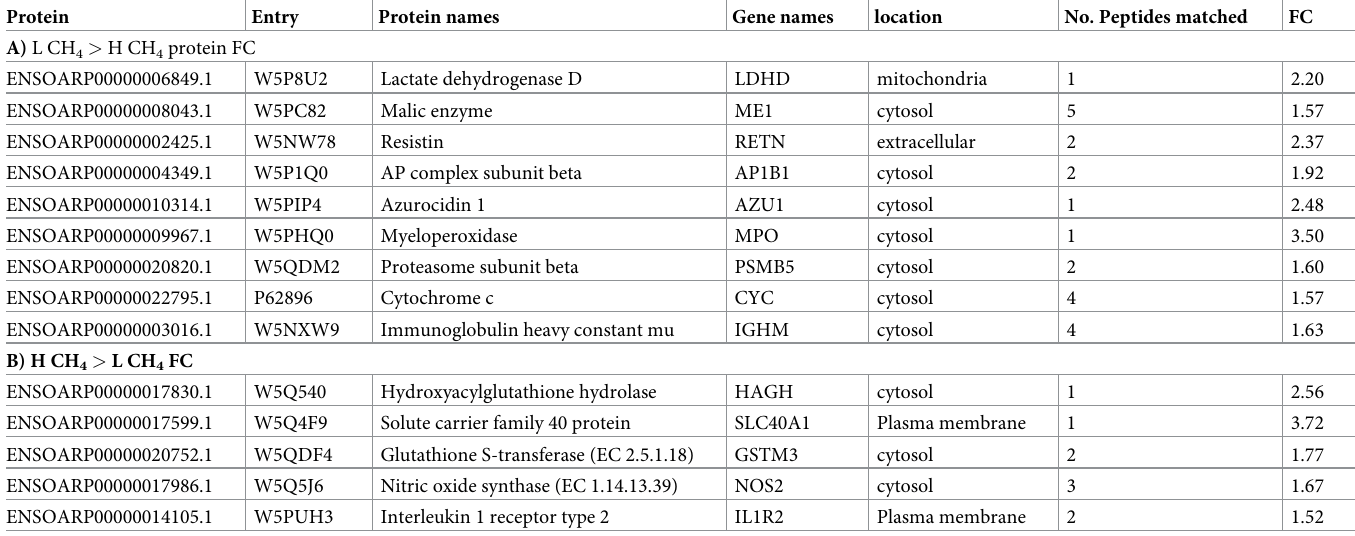
Table 2. Rumen epithelium proteins quantified with significant differences ( P < 0.05; fold change (FC) > 1.5). Fold change in protein is greater in the L compared to the H CH 4 emission phenotype A) L CH 4 > H CH 4 protein FC. Where the protein abundance is higher in the H compared to the L CH 4 emitting phenotype B) H CH 4 > L CH 4 protein FC. Accession Ensembl ( Ovis aries database), Uniprot accession code, protein and gene name from gene ontology data, number of peptides matched to the sequence and fold change are shown. Subcellular location was assigned using WoLF PSORT. For a complete list of proteins with significant differences see S1 Table.